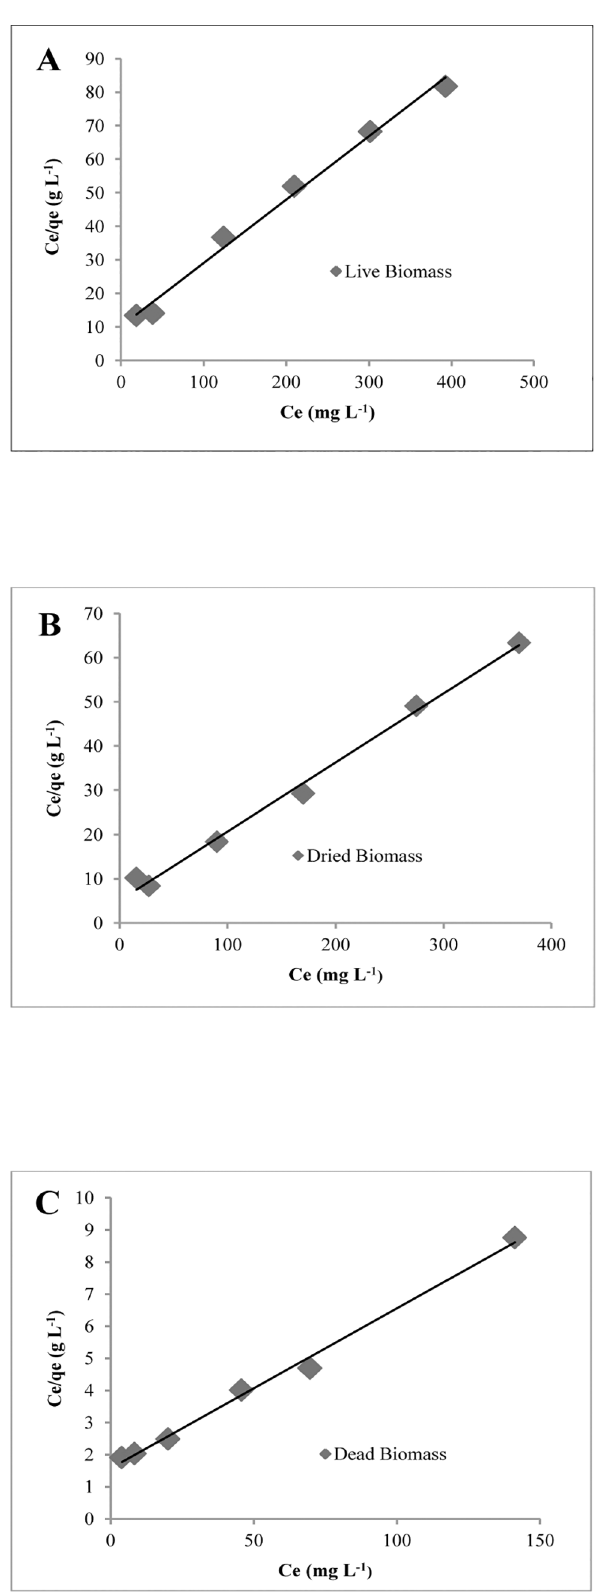
Fig 2. Equilibrium biosorption data. Langmuir plots for live (A), dried (B) and dead (C) biomass of H . lixii .